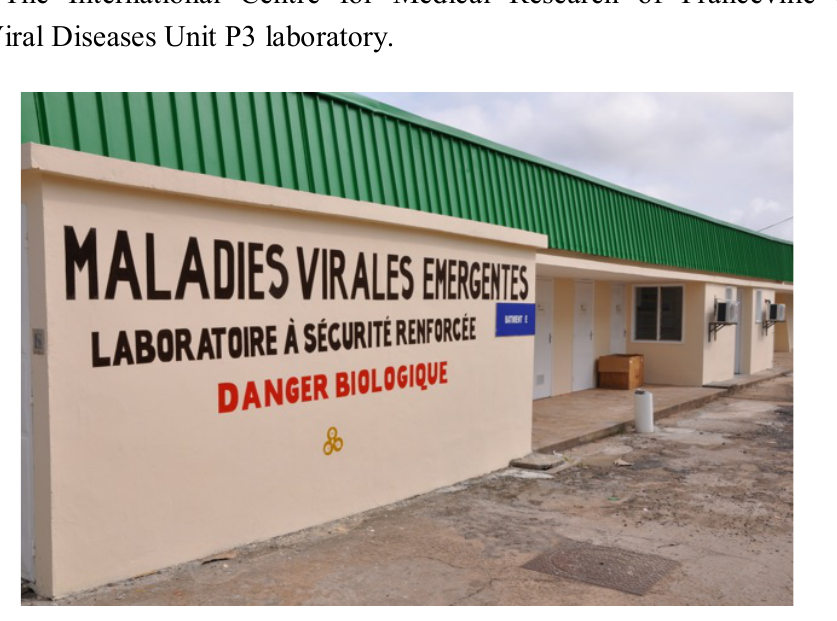
Figure 3. The Present CIRMF High Security P4 Laboratory with “Glove